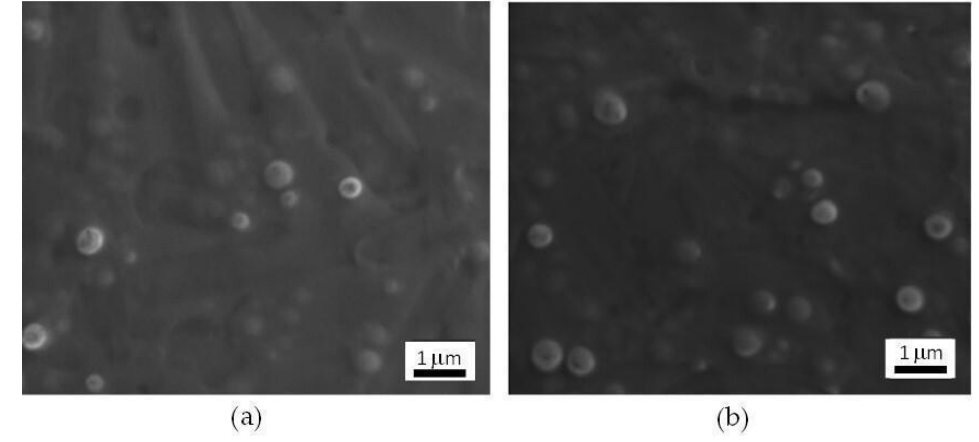
Figure 1. SEM micrographs of ( a ) NP POS 2 and ( b ) NP NEG 1.